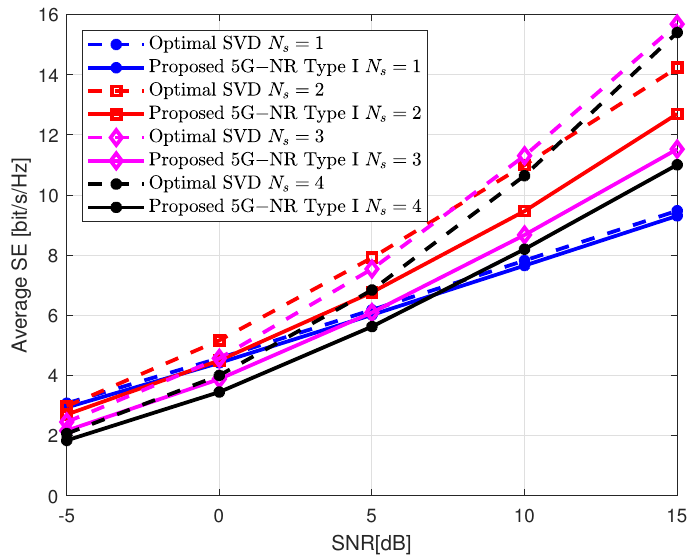
Figure 6. Average SE vs. SNR for SU-MIMO systems assuming 𝑁 𝑡 = 8, 𝑁 𝑟 = 4, and different values of 𝑁 𝑠 . The gNB is implemented assuming a multi-panel ULA with 𝑁 𝑔 = 2, 𝑁 1 = 2, and 𝑁 2 = 1.